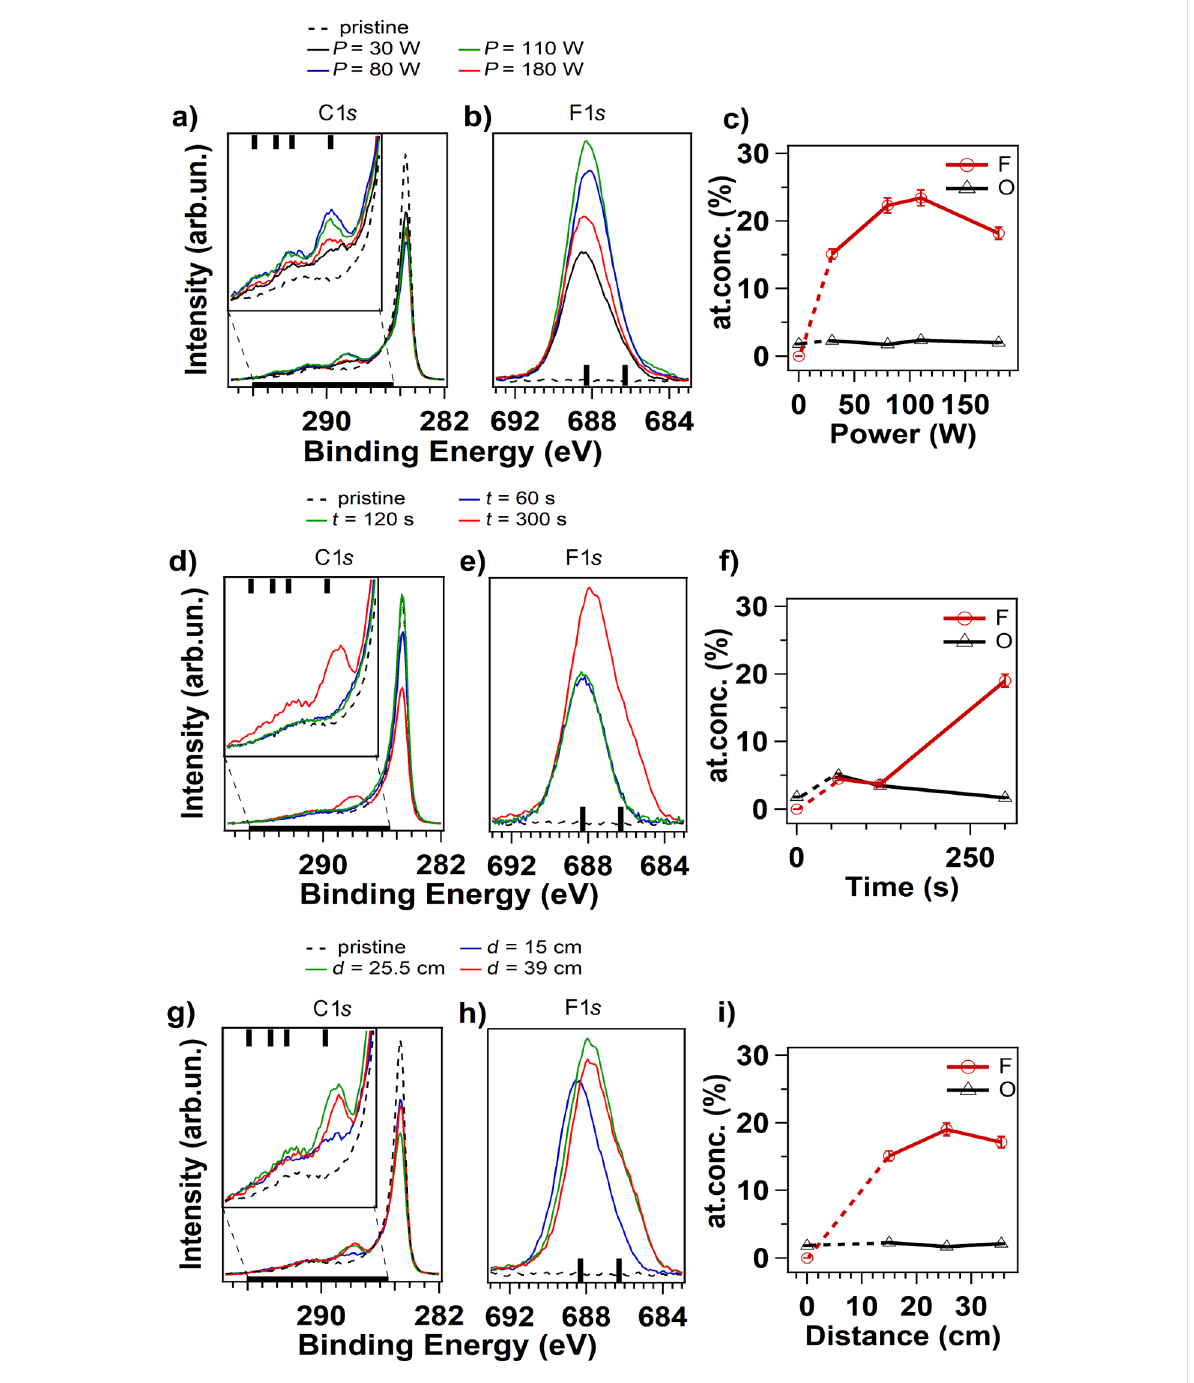
Figure 3: C 1s and F 1s core level spectra acquired from fluorinated vCNT after plasma treatments at different power (a,b), time (d,e) and distance of the sample from the plasma region (g,h). Evolution of F and O contents on various sample surfaces after plasma functionalization at different power (c), time (f) and distance (i).